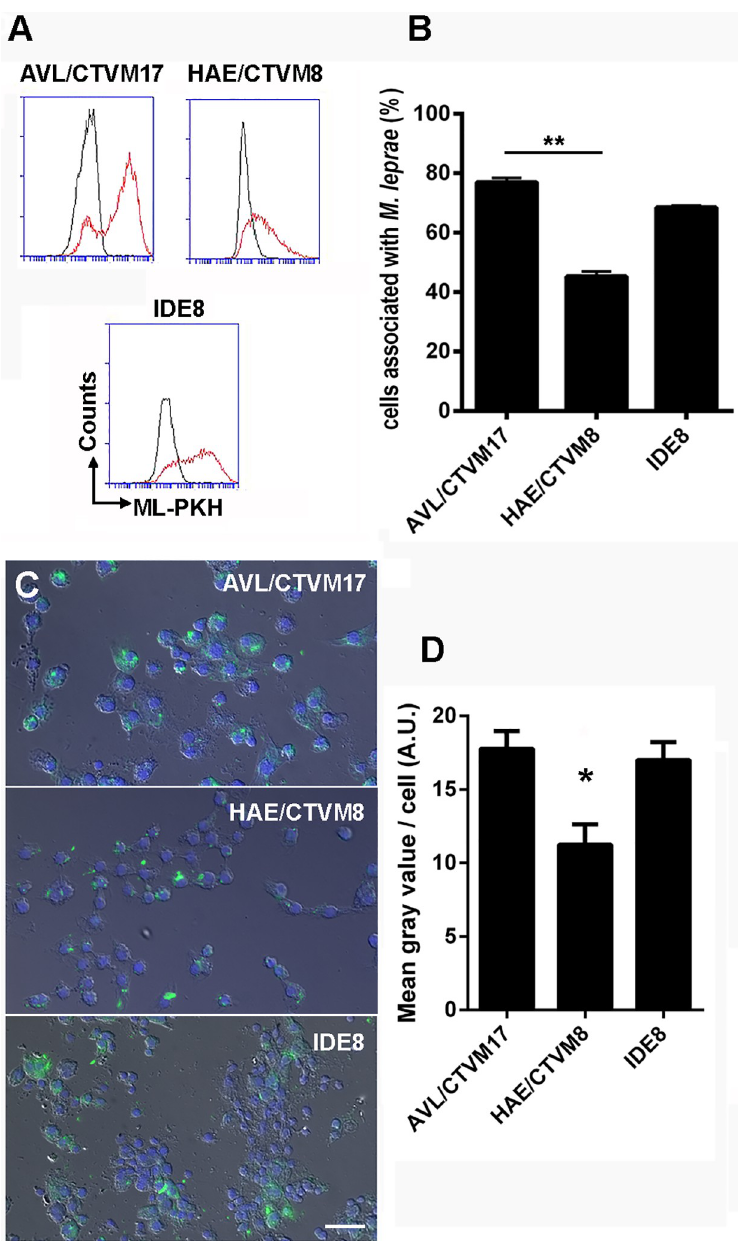
Fig 6. Mycobacterium leprae is able to associate with different tick cell lines. A) Histograms generated by flow cytometry showing association between M . leprae labelled with PKH67 and three tick cell lines: AVL/CTVM17, HAE/ CTVM8 and IDE8. Gray lines represent uninfected tick cells and red lines represent cells associated with the fluorescent bacilli. B) Quantification of the histograms in (A) demonstrating a high level of association between the pathogen and cell lines AVL/CTVM17 and IDE8. C) Fluorescence microscopy 24h after infection of tick cell lines with M . leprae labelled with the green fluorophore PKH67. D) Quantification of the mean values of fluorescence intensity/ cell in (C), for which sixty photos were analyzed from three independent experiments. Scale bar represents 20μm; �� = p < 0.005 and � = P < 0.05 by Dunn’s multiple comparisons